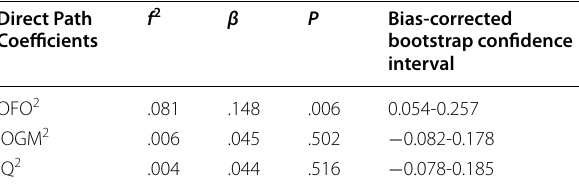
Key: OFO is organisational future orientation, IOGM is inter-organisational group mechanism, IQ is interaction quality